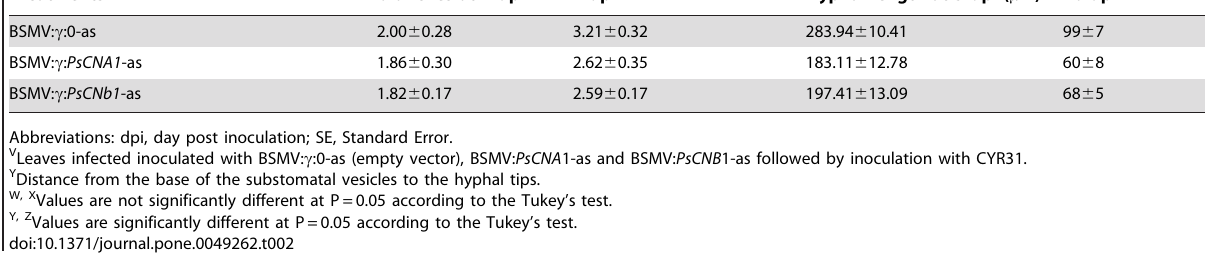
Number of hyphal branches at 2 dpi W